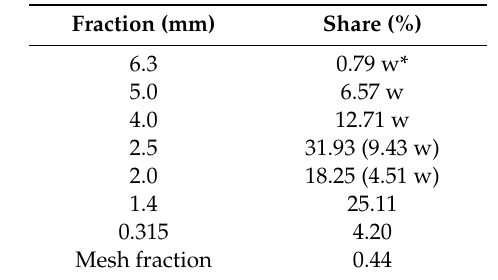
Table 2. Sawdust dimensional analysis.